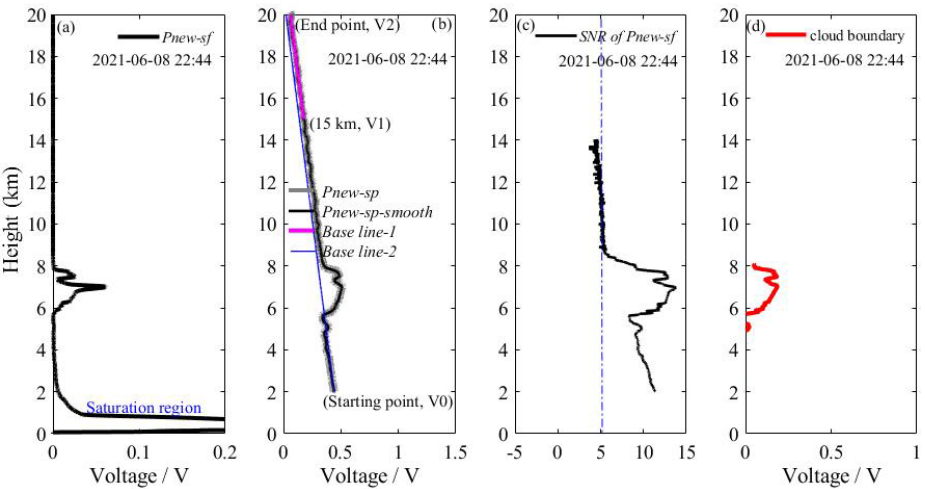
Figure 4. Detection results of lidar at 22:44CST on 8 June 2021. (a) P new_sf of the 1064nm signal, (b) P new_sp of the 1064nm signal, (c) SNR of P new_sf , and (d) cloud information